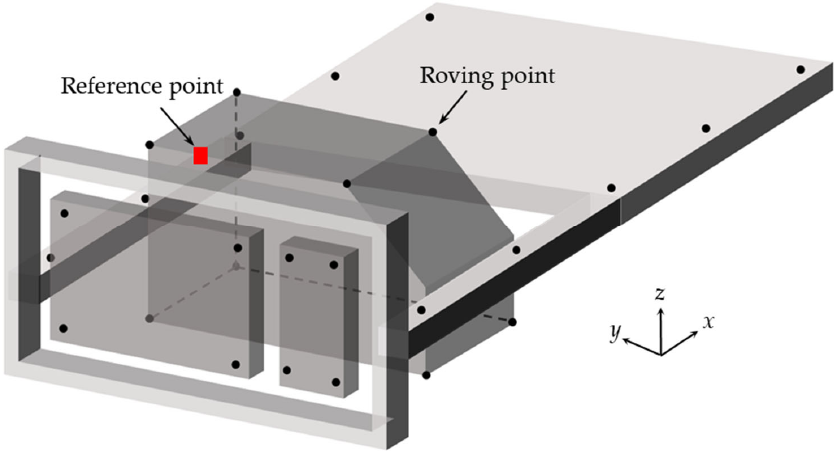
Figure 3. Measurement points of vibration signals to obtain ODSs.